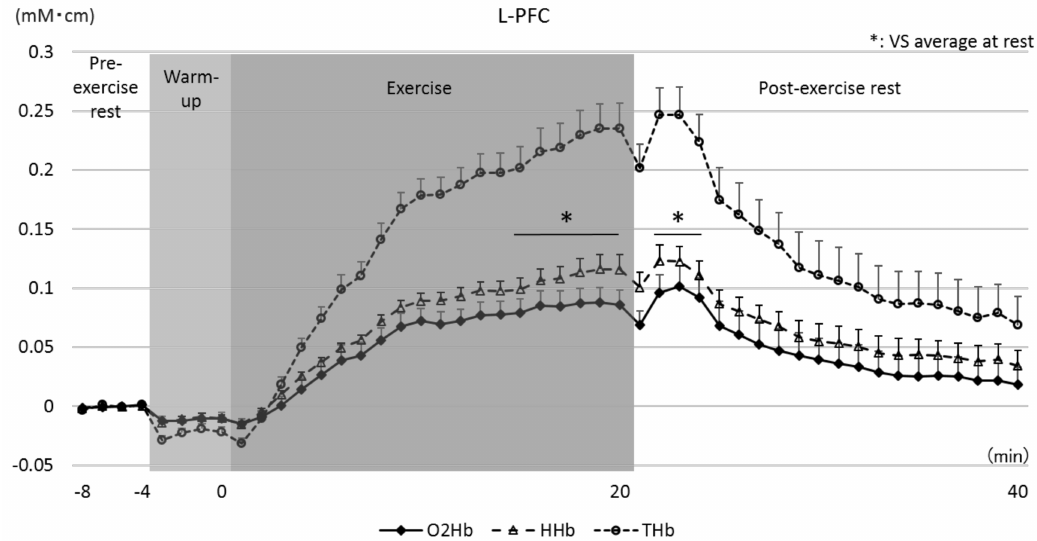
Figure 3. Oxyhemoglobin (O 2 Hb), deoxyhemoglobin (HHb), and total hemoglobin (THb) in the left prefrontal cortex (L-PFC). The circular dotted line represents total hemoglobin (THb) in the L-PFC per minute. Values are presented as the mean ± standard error of the mean (SEM). O 2 Hb levels during 15 to 20 min of exercise and 2 to 4 min of rest after exercise were significantly higher than those at rest.